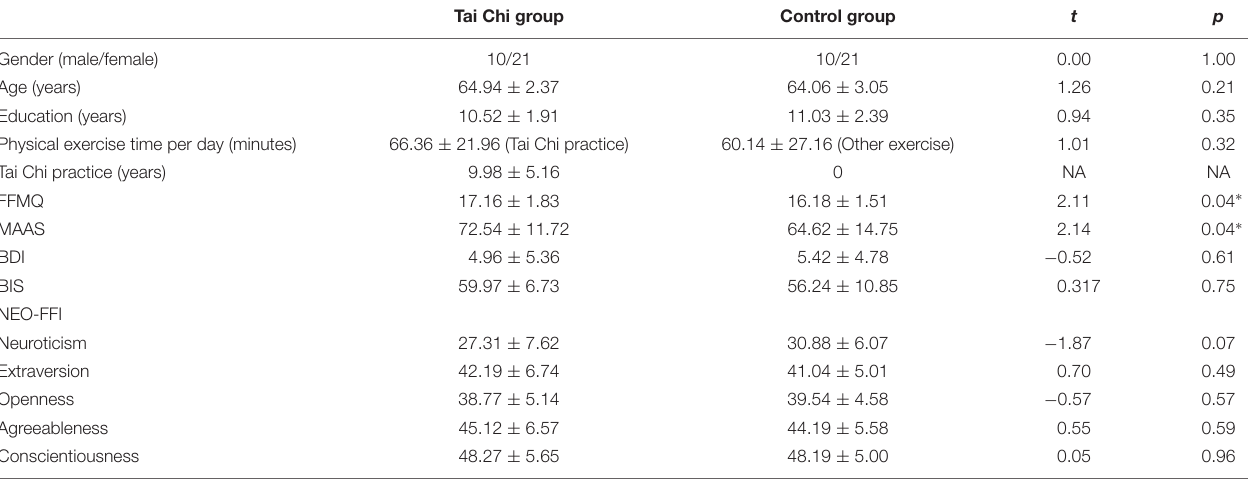
TABLE 1 | Demographics and Scale data of both groups.